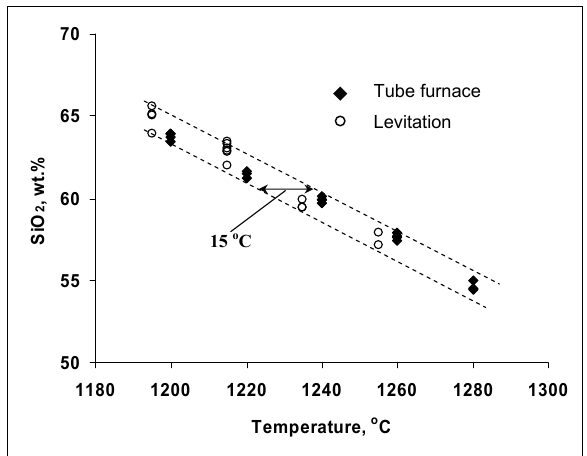
Figure 4. Comparison of the SiO 2 content in the liquids on the univariant line between the anorthite and pseudowol- lastonite phases in the CaO-SiO 2 -Al 2 O 3 system.